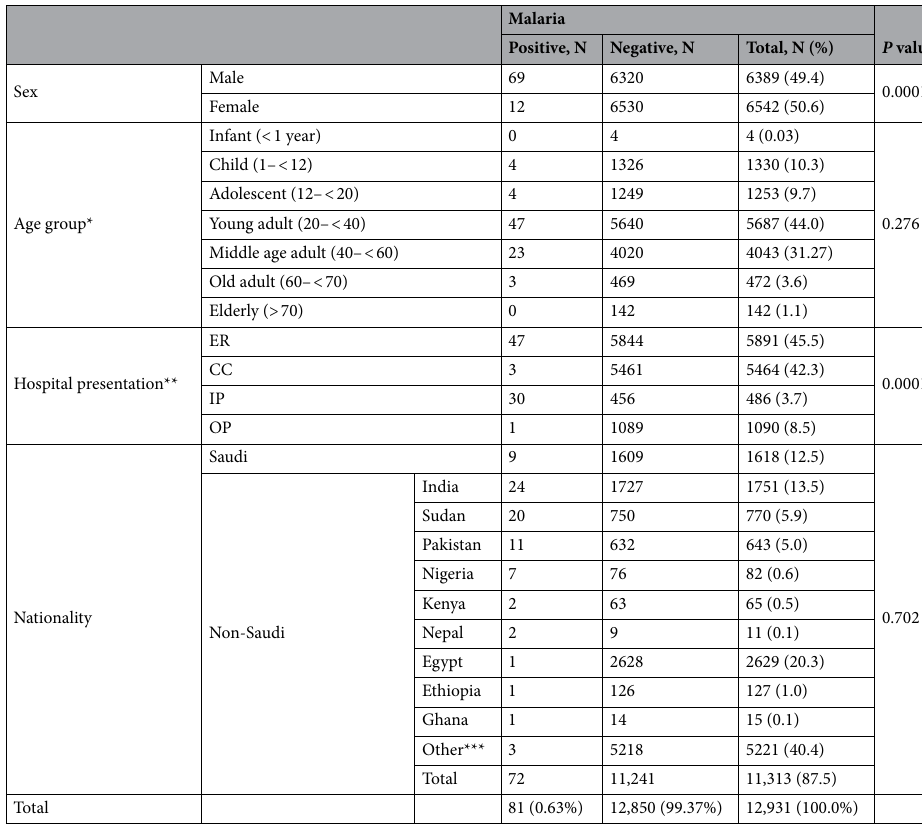
Table 1. Descriptive statistics of febrile patient data and their association with malaria infection. Proportions of categorical variables were compared using the Chi-square test. (*) P- value < 0.05 is significant